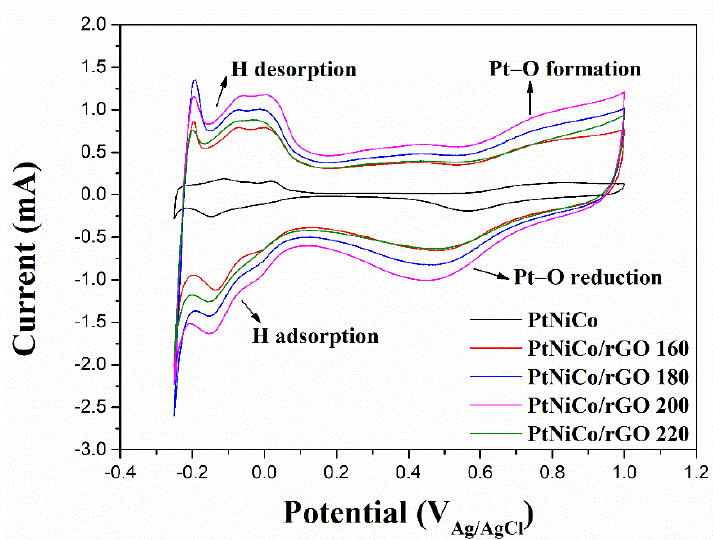
Figure 7. Electrocatalytic performance of PtNiCo, PtNiCo/rGO 160, PtNiCo/rGO 180, PtNiCo/rGO 200, and PtNiCo/rGO 220 catalysts. Cyclic voltammograms obtained at room temperature in N 2 -purged 0.5 M H 2 SO 4 aqueous solution at scan rate of 50 mV/s. The corresponding ECSA was calculated by integrating the hydrogen desorption zones and all the CV curves were normalized. According to the following formula [66]: charge ((cid:1843) , μC cm (cid:2879)(cid:2870) ) (cid:2892) ECSA (cm (cid:2870) g (cid:2879)(cid:2869) ) = (cid:16) (cid:17) 210 (μC cm (cid:2879)(cid:2870) ) × electrode loading (g Pt cm (cid:2879)(cid:2870) ) ECSA cm 2 g − 1 where Q H ( μ C cm − 2 ) is the hydrogen desorption charge, 210 ( μ C cm − 2 ) is the charge re- quired to oxidize the layer of hydrogen on Pt, and the electrode loading (g Pt cm − 2 ) is the